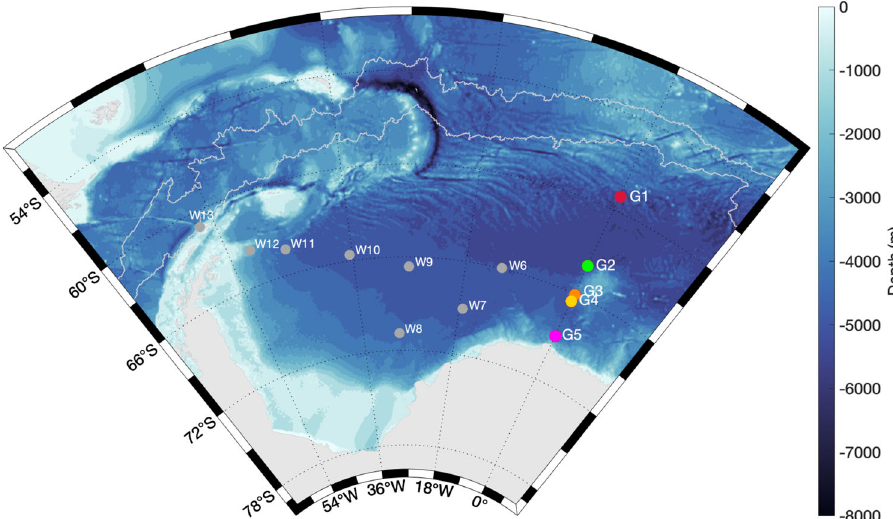
Fig. 1 The Atlantic sector of the Southern Ocean and recording positions on the Greenwich Meridian. Bathymetric map of the Atlantic sector of the Southern Ocean (ASSO) including the geographic positions of the HAFOS (Hybrid Antarctic Float Observation System) mooring network in the ASSO (coastline and bathymetry data were obtained from ref. 61, 62 ). The fi ve mooring positions, G1 – G5, visualized with colored dots (i.e., red, green, orange, yellow, and magenta), represent the recording locations of the receivers (moored between 2010 and 2018) which were analyzed during this study. Positions G1 – G5 form part of the HAFOS long-term mooring network (gray dots 14 ). The other recording positions (W6 – 13) were only active during 2013 and were, therefore, not included here (but see ref. 25 for details). Light gray lines represent the minimum and maximum of the annual wintertime (21 June – 21 September) maximum sea ice extent during the study period (2011 – 2018) 63 . Please note, that the lines shown do not delineate the sea ice extent of the speci fi c years with the maximum and minimum wintertime maximum sea ice extent, but - calculated independently for each longitude — the multi-year composite of the maximum and minimum of the wintertime maximum sea ice extent during this